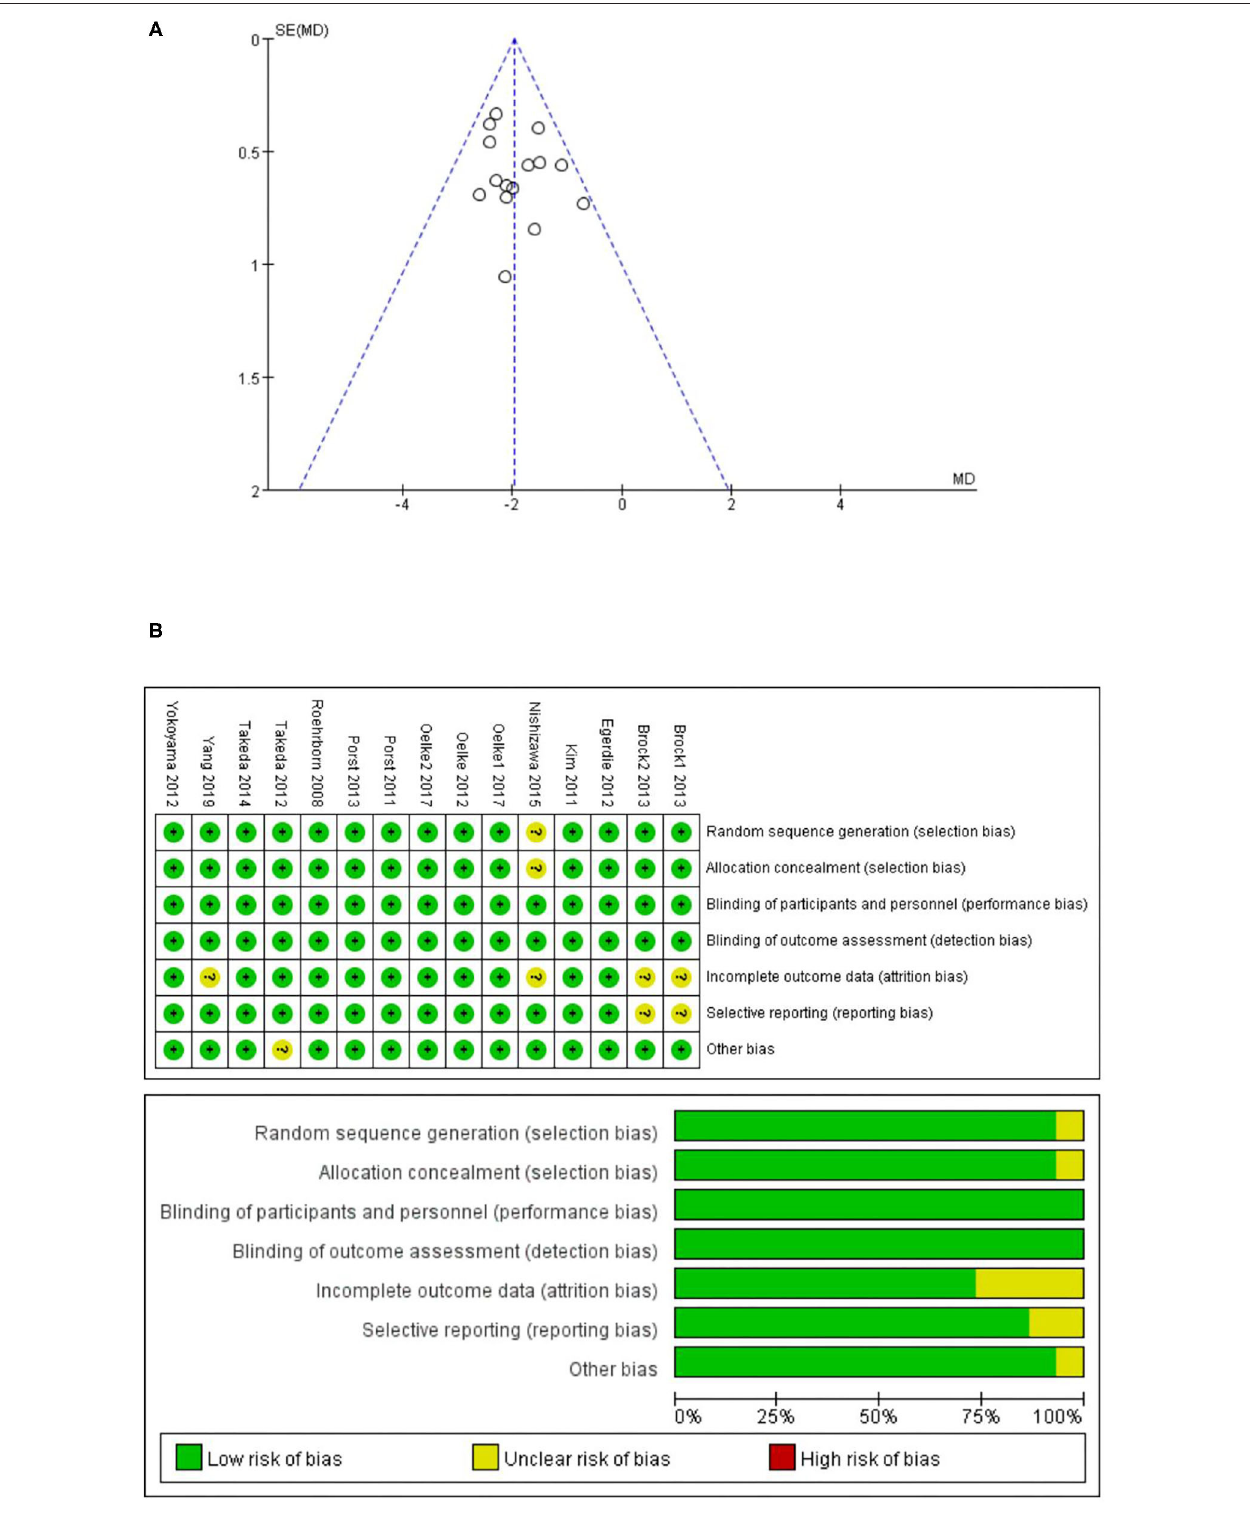
FIGURE 2 | (A) Funnel plot of the studies represented in our meta-analysis; (B) risk of bias graph summary and risk of bias graph.